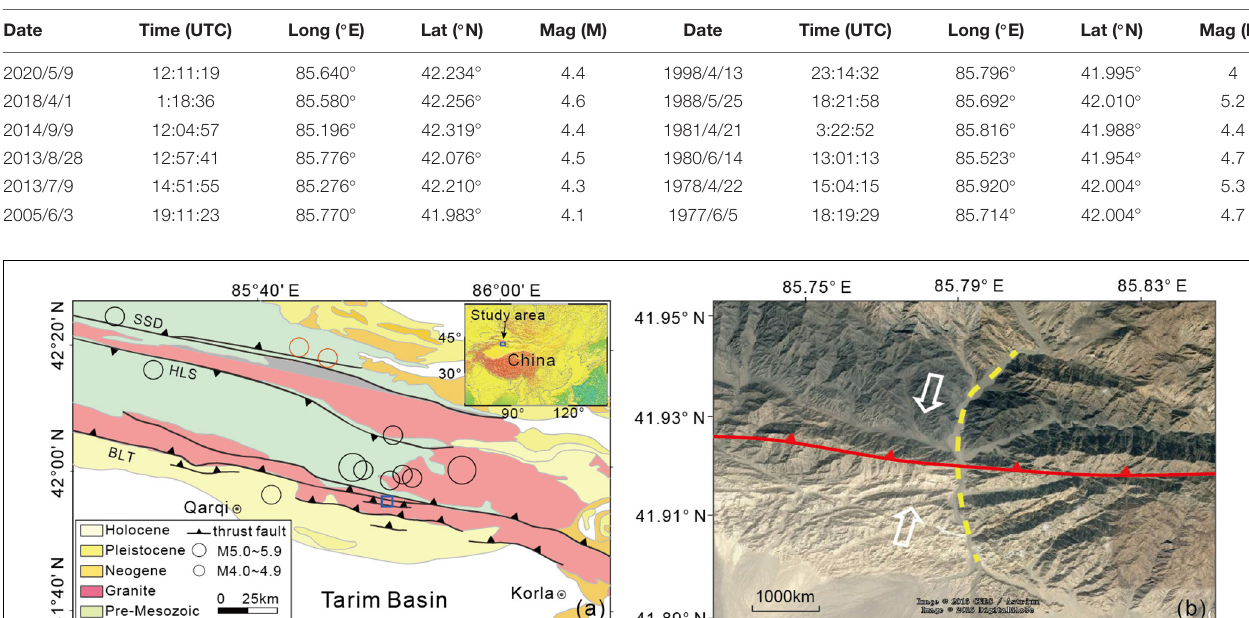
TABLE 1 | Catalog of earthquakes occurring in the area near Tiemenguan from January 1, 1970 to May 31, 2020.